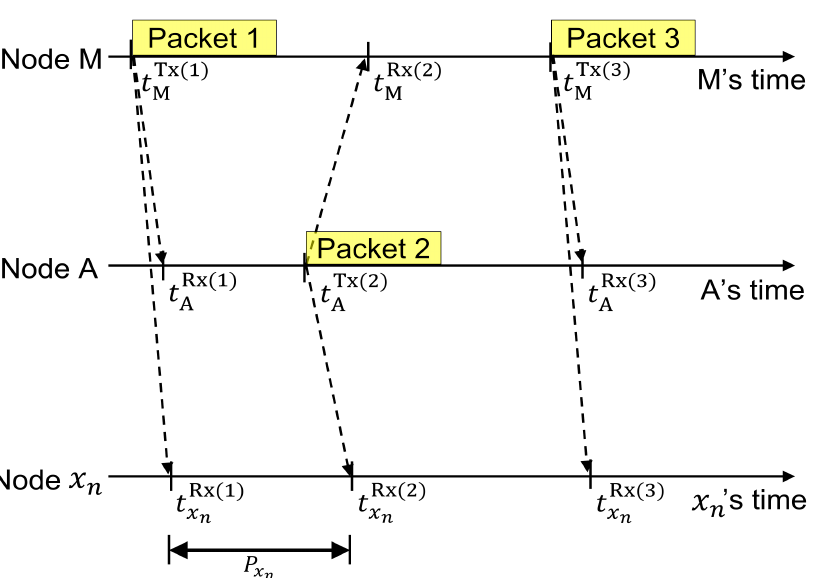
( k ) ( k ) and t Rx i i